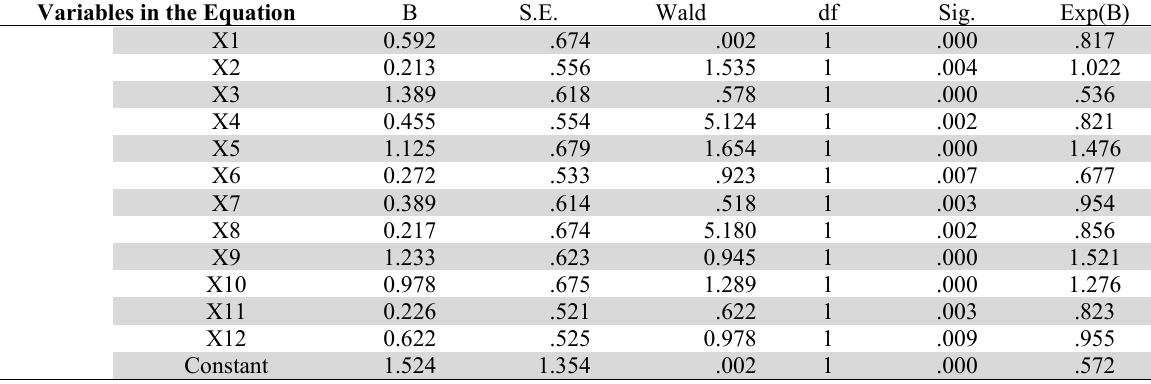
Table 8 Results for the binary logistic regression model Variables in the Equation